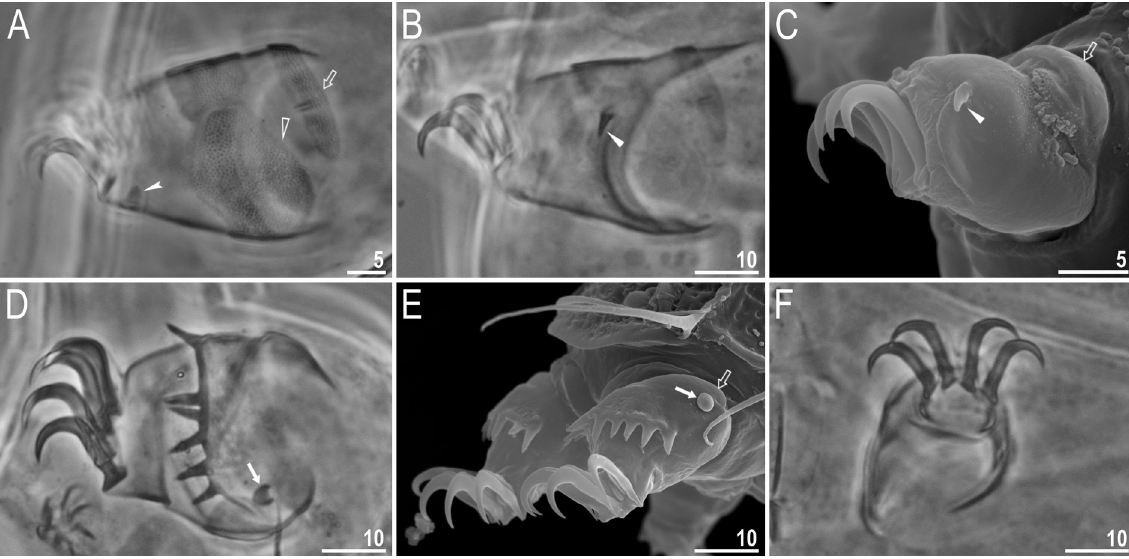
Fig. 4. Echiniscus quadrispinosus Richters, 1902, ♀. A* . Leg I outer cuticle with clearly visible stripes of tiny and regular granulation: a thin frontal stripe on the upper part of the leg (empty arrow), a wide stripe in the central part of the leg covering frontal and lateral side of the leg (empty arrowhead) and the most distal, thin stripe above claws on the ventral side of the leg (filled indented arrowhead) (PCM). B . Spine on leg I (arrowhead) (PCM). C . Spine on leg I (arrowhead) and thin frontal stripe on the upper part of the leg (empty arrow) (SEM). D* . Claws IV with dentate collar and finger-like papilla (filled arrow) (PCM). E . Vlaws IV with dentate collar and finger-like papilla (filled arrow); empty arrow indicates thin frontal stripe on the upper part of the leg (SEM). F . Claws of the II leg (PCM). * = manually assembled deep-focus image. Scale bars in micrometres